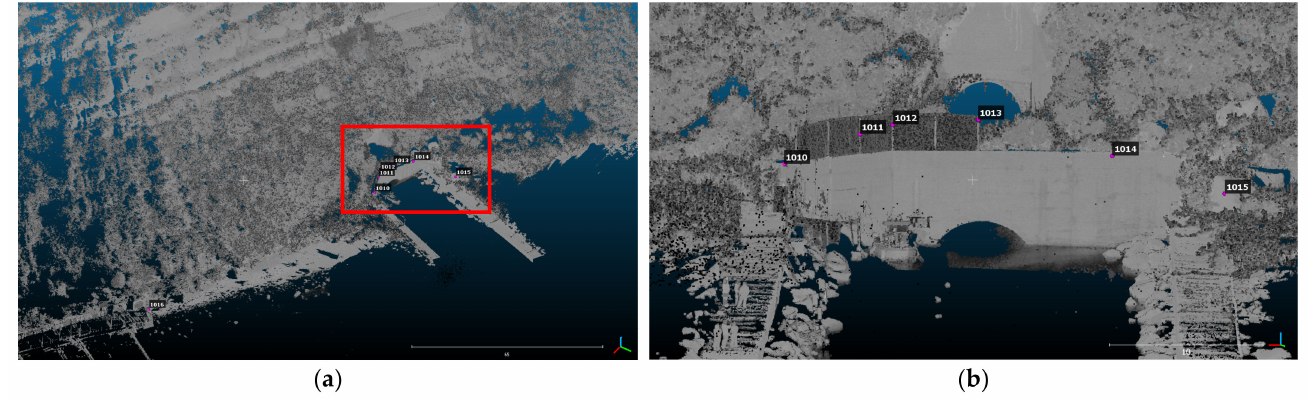
Figure 4. Position of the reflectors in the surveyed scene: ( a ) general view from the east; ( b ) detail of the red box shown in